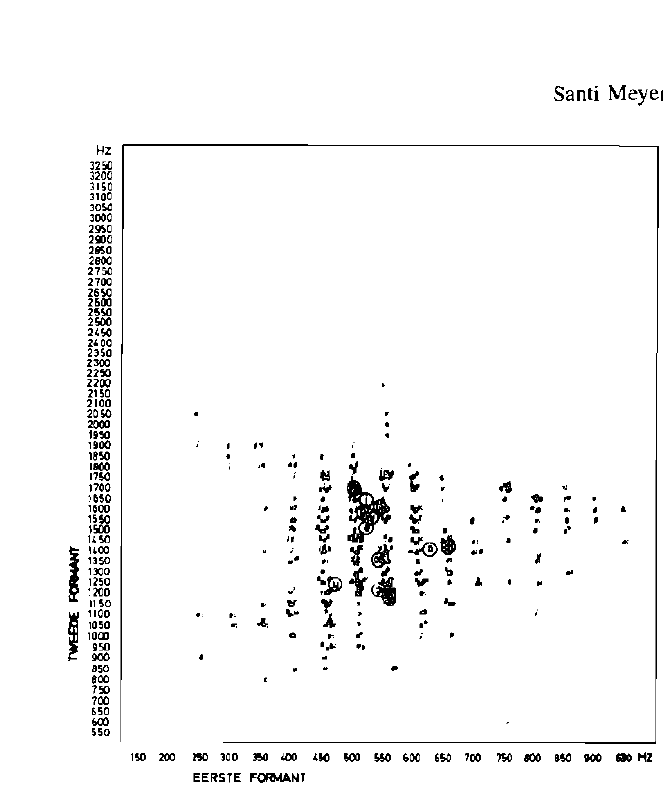
Figuur 3 Die eerste- en tweedeformantfrekwensies van vokale geproduseer deur normaalhorendes